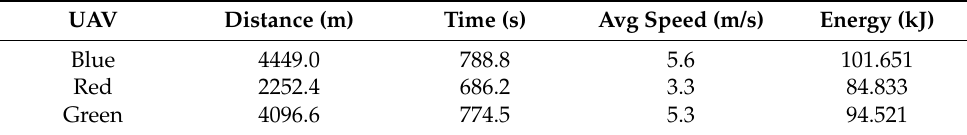
Table 3. Statistics for the Paths Shown in Figure